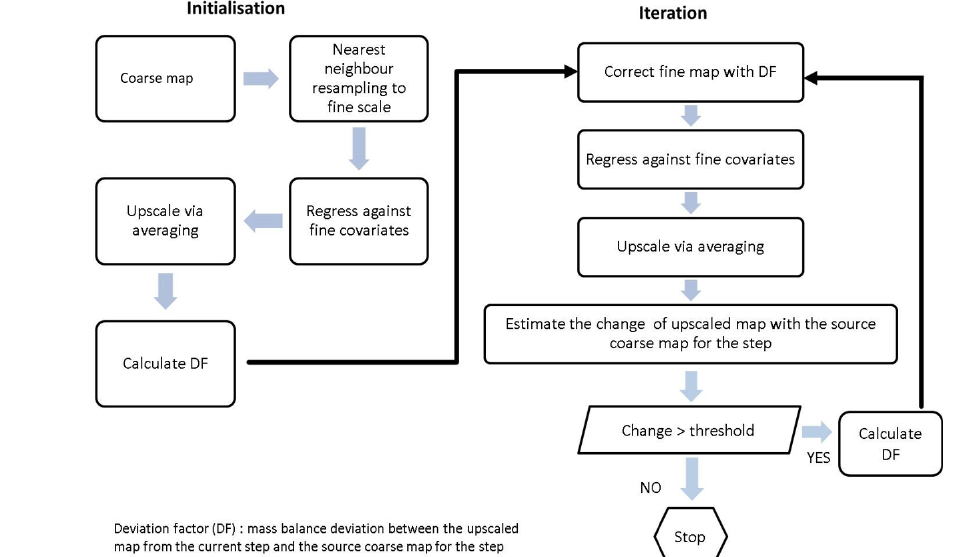
Figure 3. Schematic representation of dissever disaggregation technique.